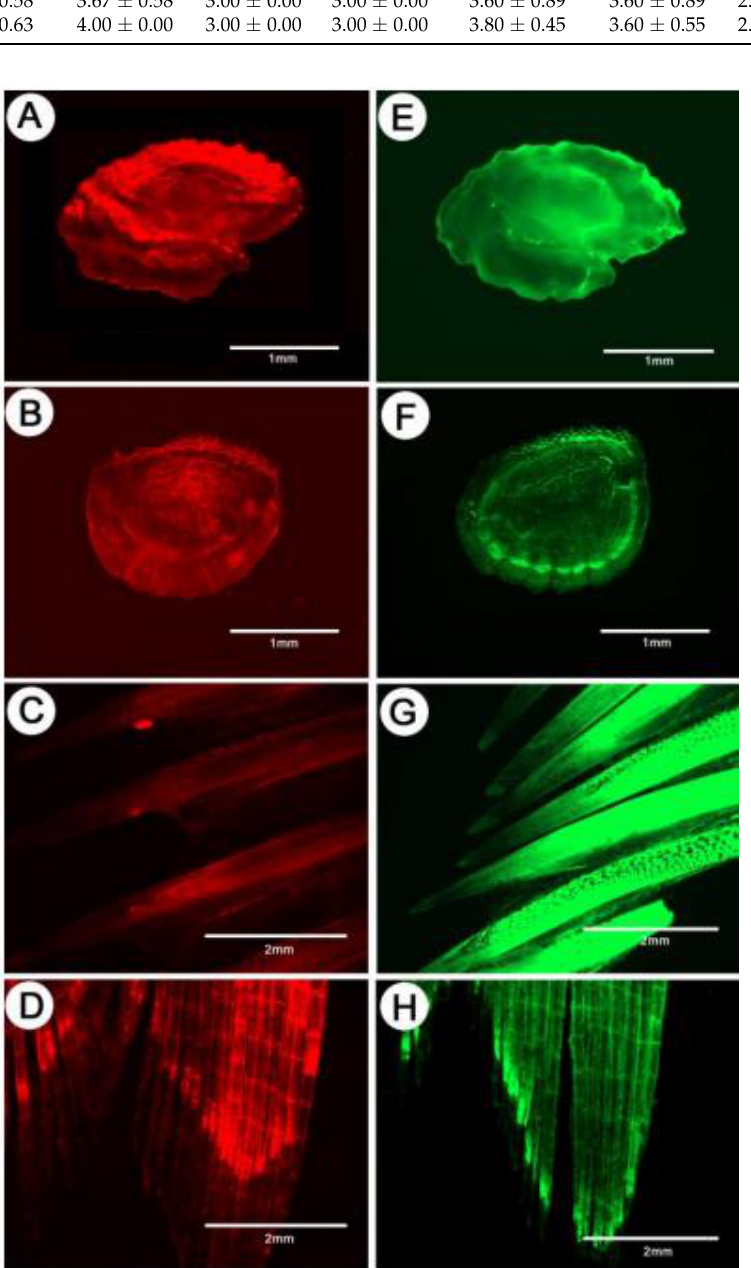
Figure 2. Marking quality of otolith ( A , E ), scale ( B , F ), fin ray ( C , G ) and fin spine ( D , H ) using ARS under green light ( A – D ) and CAL under blue light ( E – H ). Scale bars: A , B , E , F = 1 mm, C , D , G , H = 2 mm.